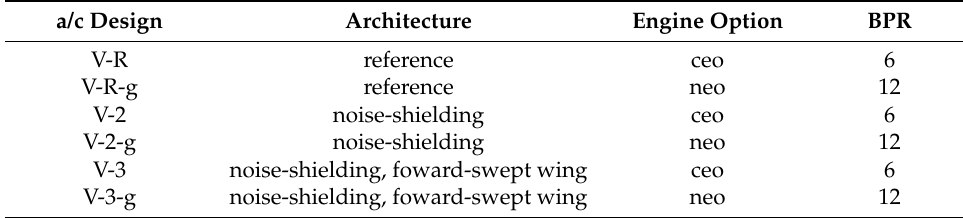
Table 3. Aircraft designs considered in